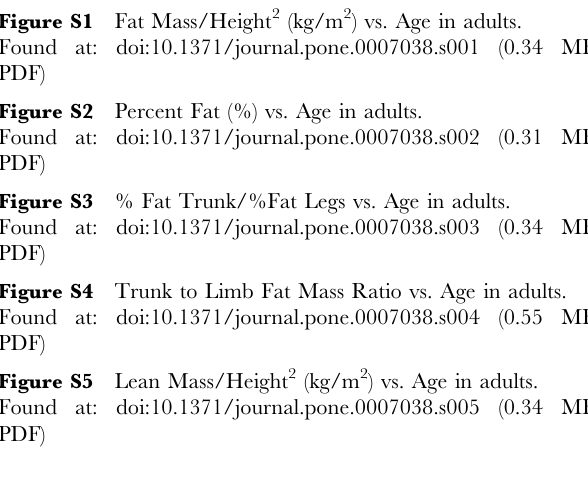
Figure S1 Fat Mass/Height 2 (kg/m 2 ) vs. Age in adults. Found at: doi:10.1371/journal.pone.0007038.s001 (0.34 MB Figure S2 Percent Fat (%) vs. Age in adults. Found at: doi:10.1371/journal.pone.0007038.s002 (0.31 MB Figure S3 % Fat Trunk/%Fat Legs vs. Age in adults. Found at: doi:10.1371/journal.pone.0007038.s003 (0.34 MB Figure S4 Trunk to Limb Fat Mass Ratio vs. Age in adults. Found at: doi:10.1371/journal.pone.0007038.s004 (0.55 MB Figure S5 Lean Mass/Height 2 (kg/m 2 ) vs. Age in adults. Found at: doi:10.1371/journal.pone.0007038.s005 (0.34 MB